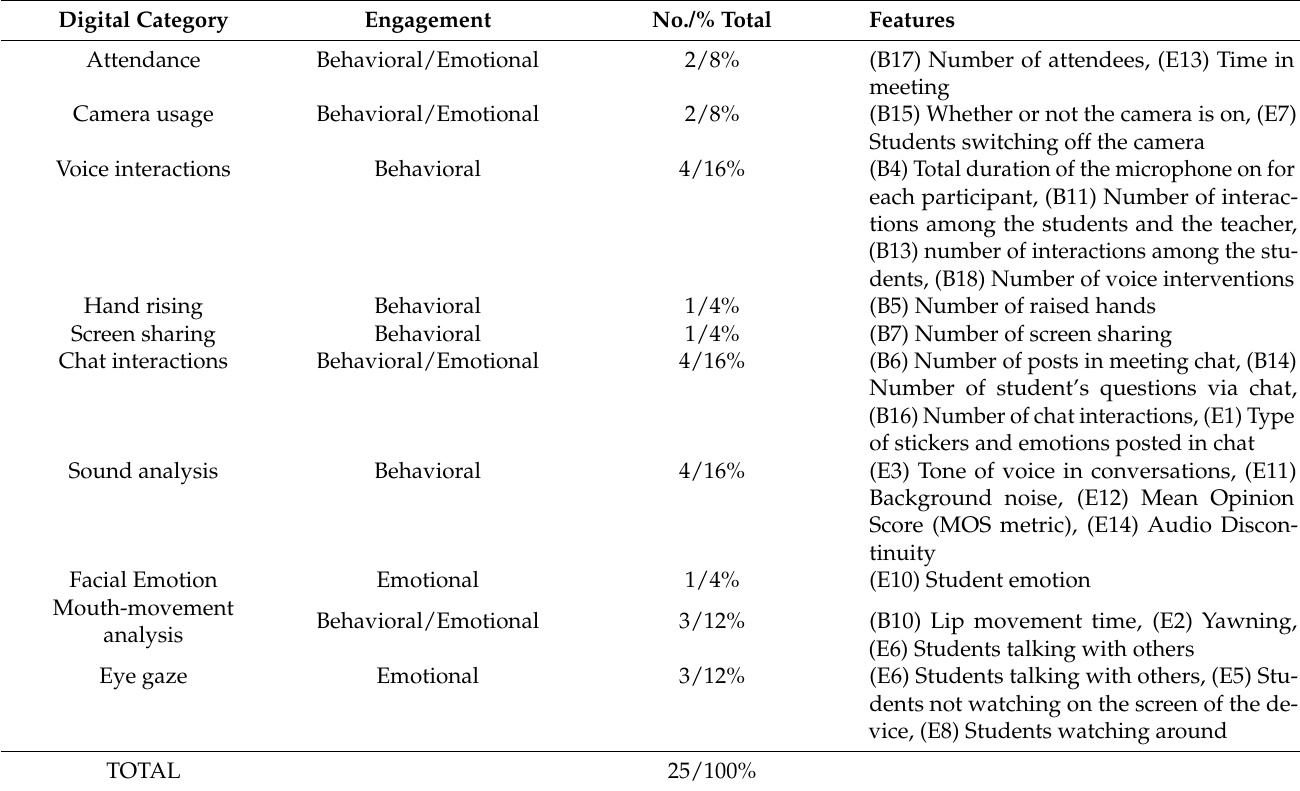
Table 6. Result of grouping the 25 features obtained at the Feature Identification stage into 10 digital